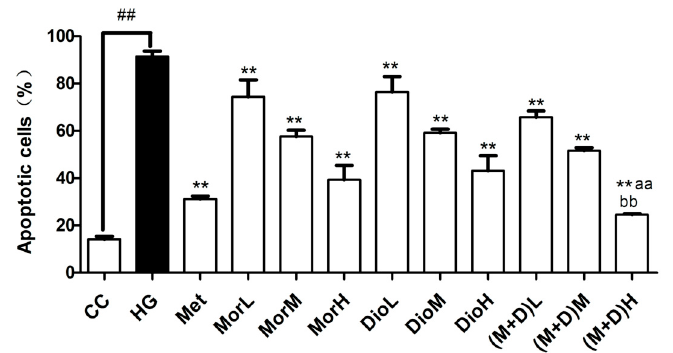
Figure 2. Effect of Mor (25, 50, 100 μ g/mL), Dio (25, 50, 100 μ g/mL), and M + D (25, 50, 100 μ g/mL) on HG-induced cardiomyocyte apoptosis. (M + D)H significantly prevents from cardiomyocytes apoptosis as determined with TUNEL staining. Data are expressed as mean ± SD. ## p < 0.01 vs. CC; ** p < 0.01, vs. HG; aa p < 0.01, vs. MorH; bb p < 0.01, vs. DioH.